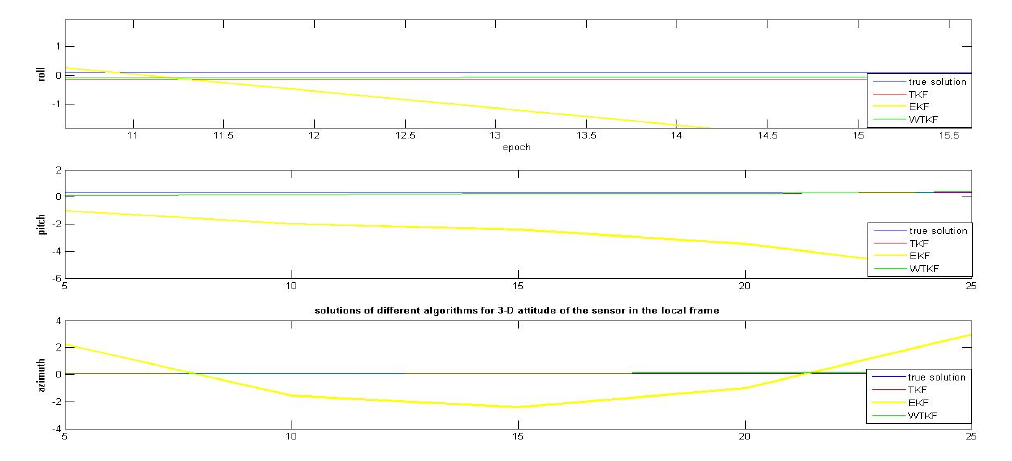
Figure 4-b: the solution of different algorithms for 3-D attitude of the sensor in a local frame Section 3-2: IKF versus EKF and